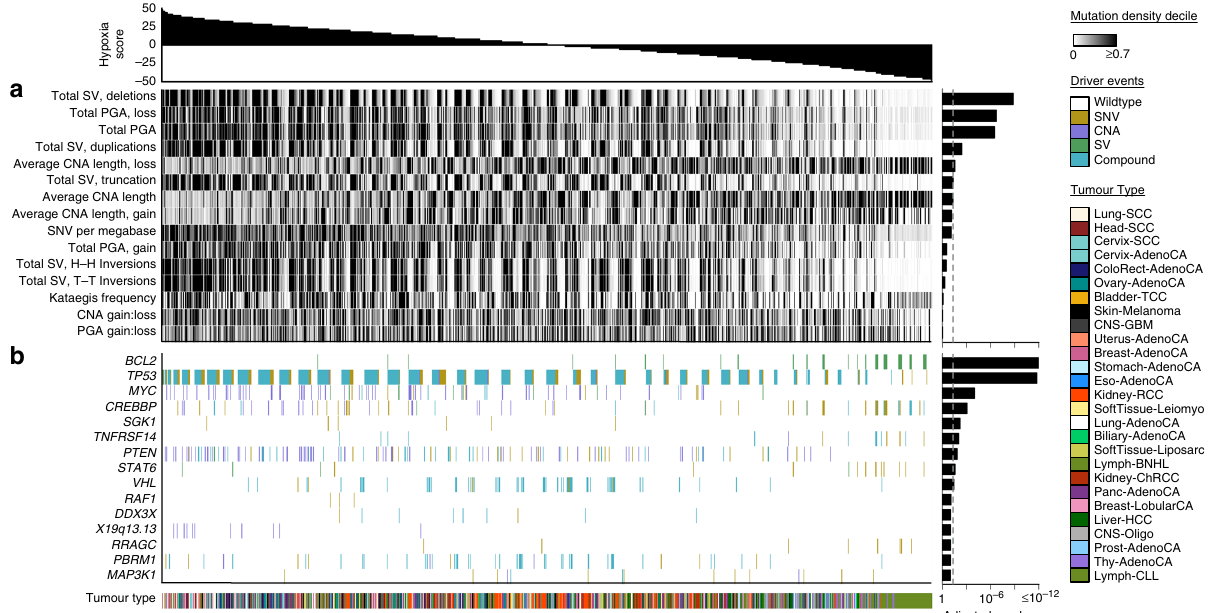
Fig. 2 The genomic correlates of tumour hypoxia. We associated tumour hypoxia with mutational density and summary features, a , and driver mutations, b , across 27 cancer types using linear mixed-effect models. Hypoxia scores for all 1188 tumours are shown along the top. a Elevated tumour hypoxia was strongly associated with more deletions, elevated PGA, smaller CNAs, and a higher number of SNVs per megabase ( n = 1188 independent tumours). Bonferroni-adjusted p -values are shown on the right. b We tested if driver mutations (e.g. any of SNV, CNA, SV or a compound event with more than one type of mutation) were associated with hypoxia in 1096 independent tumours with driver mutation data. Tumours with mutations in BCL2 showed lower levels of hypoxia while patients with mutations in TP53 showed remarkably elevated tumour hypoxia. Other driver mutations associated with elevated hypoxia include the oncogene MYC and the tumour suppressor PTEN . FDR-adjusted p -values are shown along the right. SV structural variant; PGA percentage of the genome with a copy-number aberration; CNA copy-number aberration; SNV single nucleotide variant; H-H head-to-head; T-T tail-to-tail. All associations were modelled using linear mixed-effect models while adjusting for cancer type, tumour purity, age and hypoxic tumours have elevated genomic instability while con- trolling for cancer type, tumour purity, age and sex 27 ( p = 2.41 × = 0.022, R 2 = 0.57, linear mixed-effect 10 − 8 , R 2 LMEM (cid:1) M LMEM (cid:1) C model; Fig. 2a).